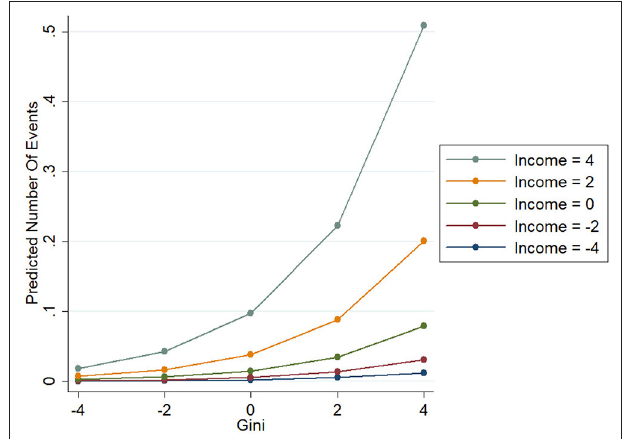
FIGURE 1 | Linear prediction of mass shootings by various levels of household income and income inequality. Variables reported as standard